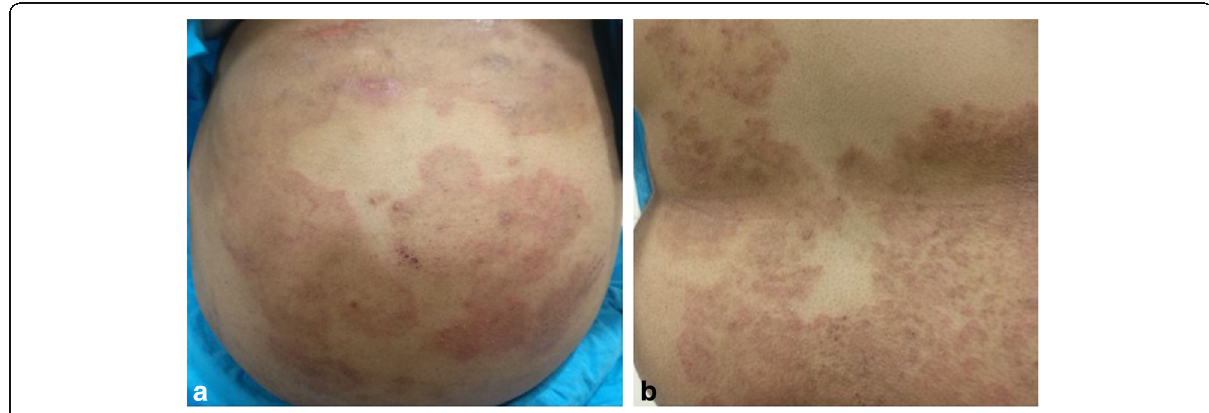
Fig. 4 a , b Color photograph of the abdomen and back showing extensive reddish color erythematous plaque-like skin